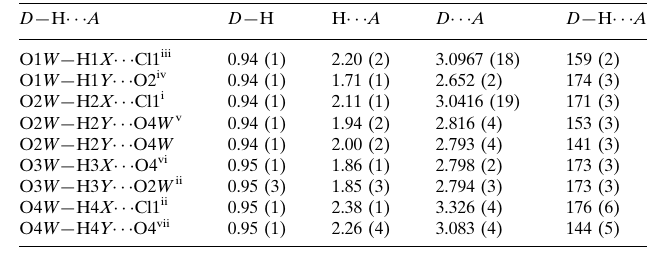
Hydrogen-bond geometry (A˚ , (cid:3)